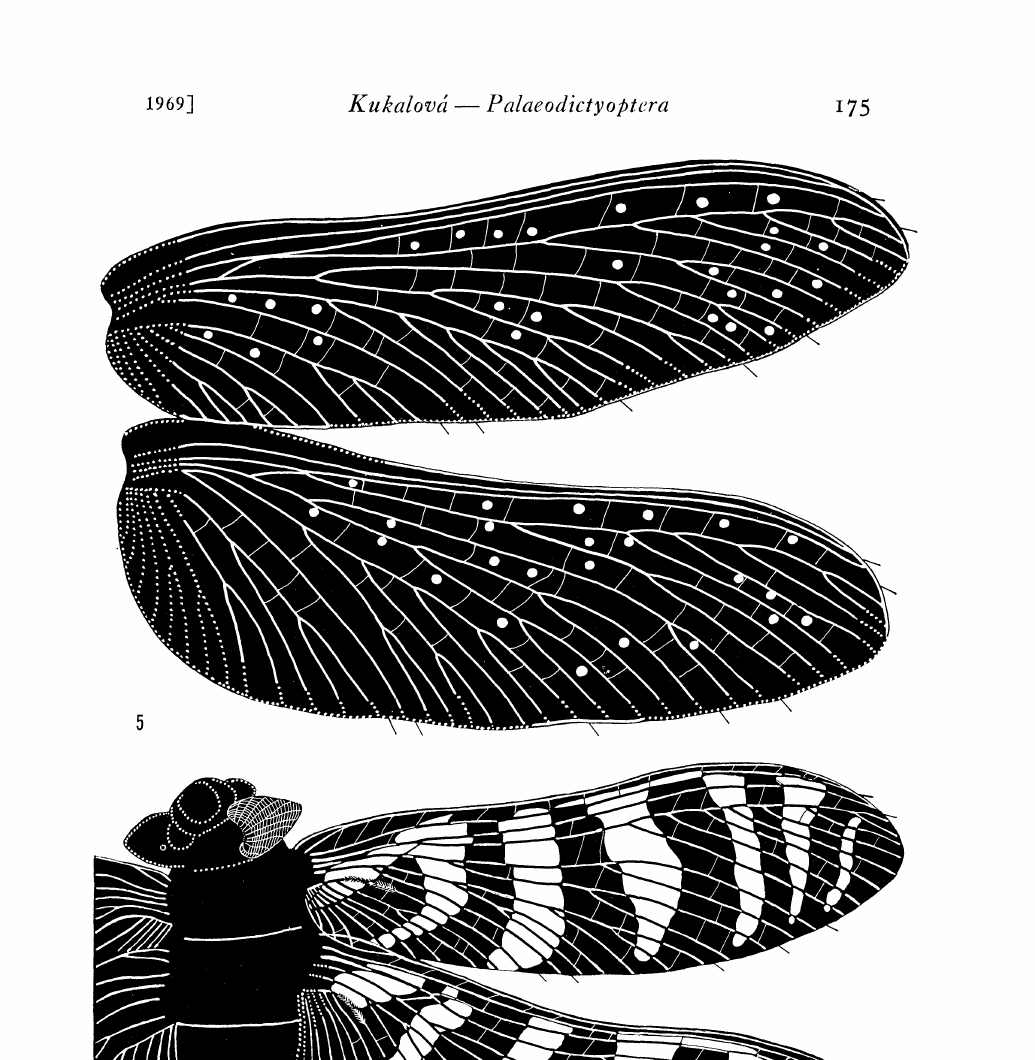
Figure 5. Homaloneura punctata Brongniart; specimen 17-13. Holotype. Figure 6. Homaloneura joannae Brongniart; specimen 18-5.